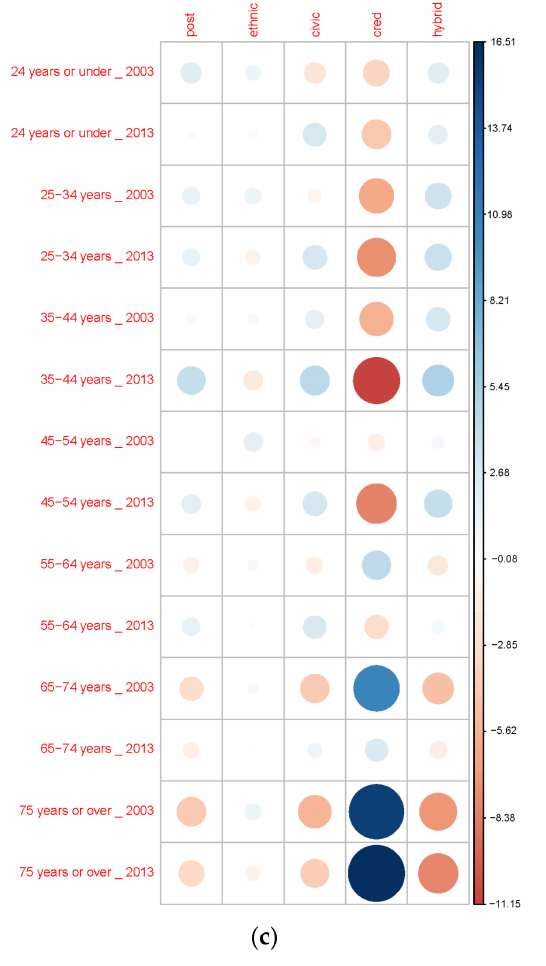
Figure 3. Pearson Residuals. Contingency Tables; ( a ) country-year; ( b ); political orientation-year; ( c )